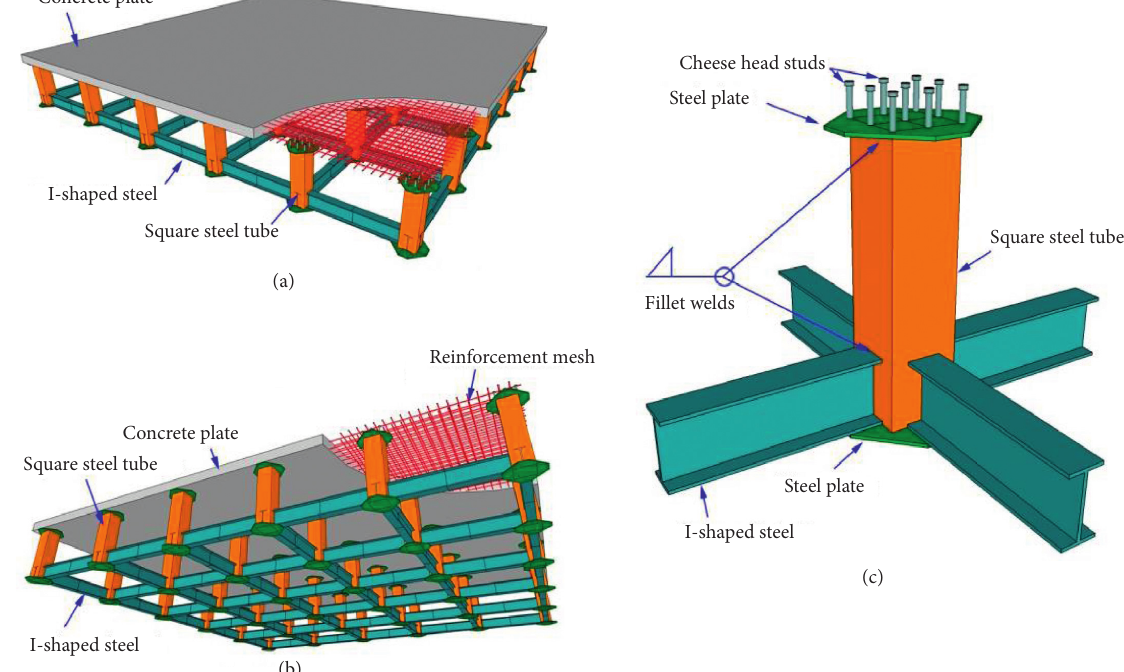
Figure 2: Details of composite floor system. (a) Overhead view. (b) Upward view. (c) Schematic view of